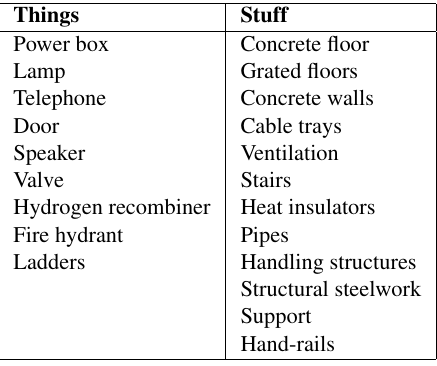
Table 1. Classes of things and stuff objects from a power plant